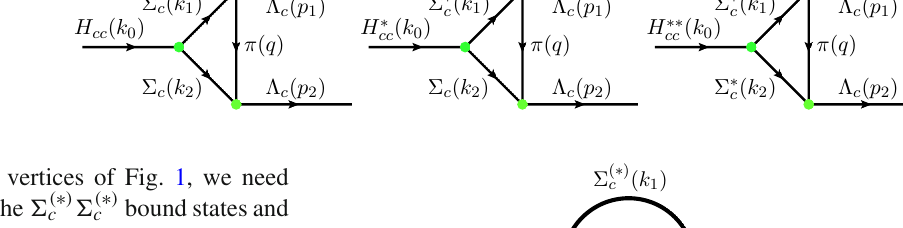
Fig. 1 Triangle diagrams of (cid:2) ( ∗ ) (cid:2) ( ∗ ) c c molecules decaying into (cid:3) c (cid:3) c by exchanging a π meson